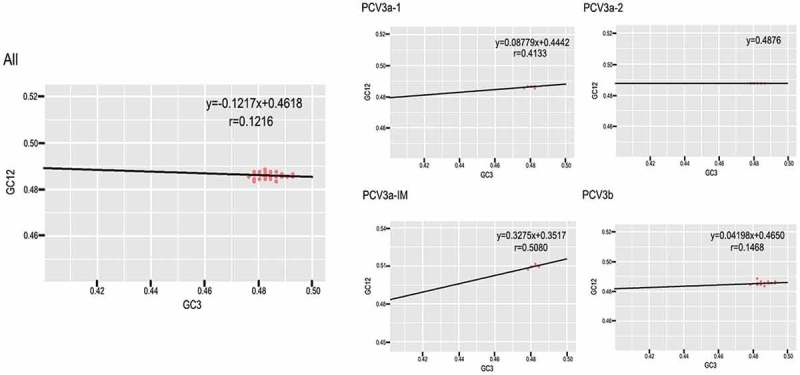
Neutrality plot analysis (GC12s plotted against GC3s) for all the coding sequences of PCV3 and the different genotypes.